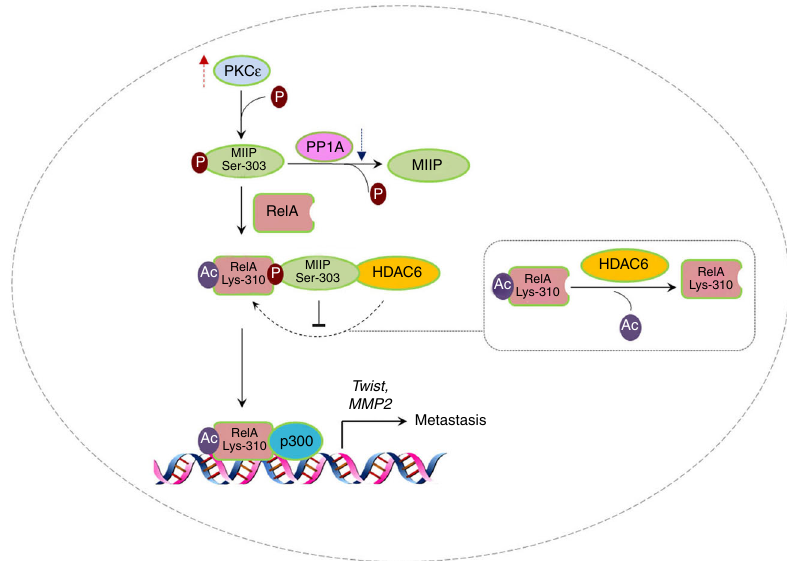
Fig. 7 A schematic diagram of model displaying the implication of MIIP in PKC ε activation-induced tumor metastasis. PKC ε phosphorylates MIIP at Ser303 and promotes its interaction with RelA, which protects RelA from deacetylation by HDAC6; in turn, this leads to enhancement of RelA transcriptional activity and increase of genes expression relevant to cell invasion. PP1 acts as a phosphotase being able to dephosphorylate MIIP phosphorylation by PKC ε . In cancer cells, PKC ε activity is hyperactive while PP1 protein levels is downregulated; thereby, PKC ε /MIIP/RelA signaling is reinforced and faciliates tumor